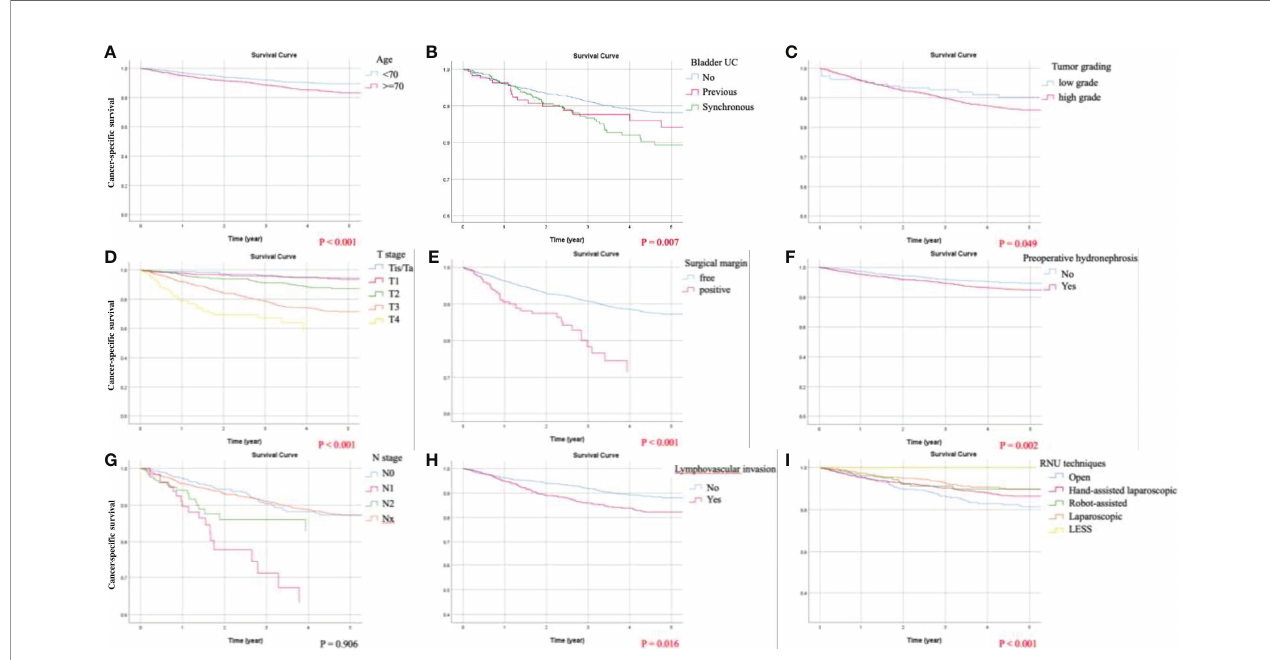
FIGURE 3 | Kaplan-Meier curves of cancer-speci fi c survival (CSS) following adjustment for age, tumor size, preoperative hydronephrosis, middle ureteral, distal ureteral or bladder cuff urothelial carcinoma (UC), multifocal UCs, previous or synchronous bladder UC, lymphovascular invasion (LVI), tumor necrosis, surgical margin, tumor grading, cell type, pathological T and N staging, and surgical approaches of radical nephroureterectomy (RNU). Signi fi cant predicting factors for CSS included: (A) age, (B) chronological history of bladder UC, (C) tumor grading, (D) T stage, (E) surgical margin, (F) preoperative hydronephrosis, (H) LVI, and (I) RNU